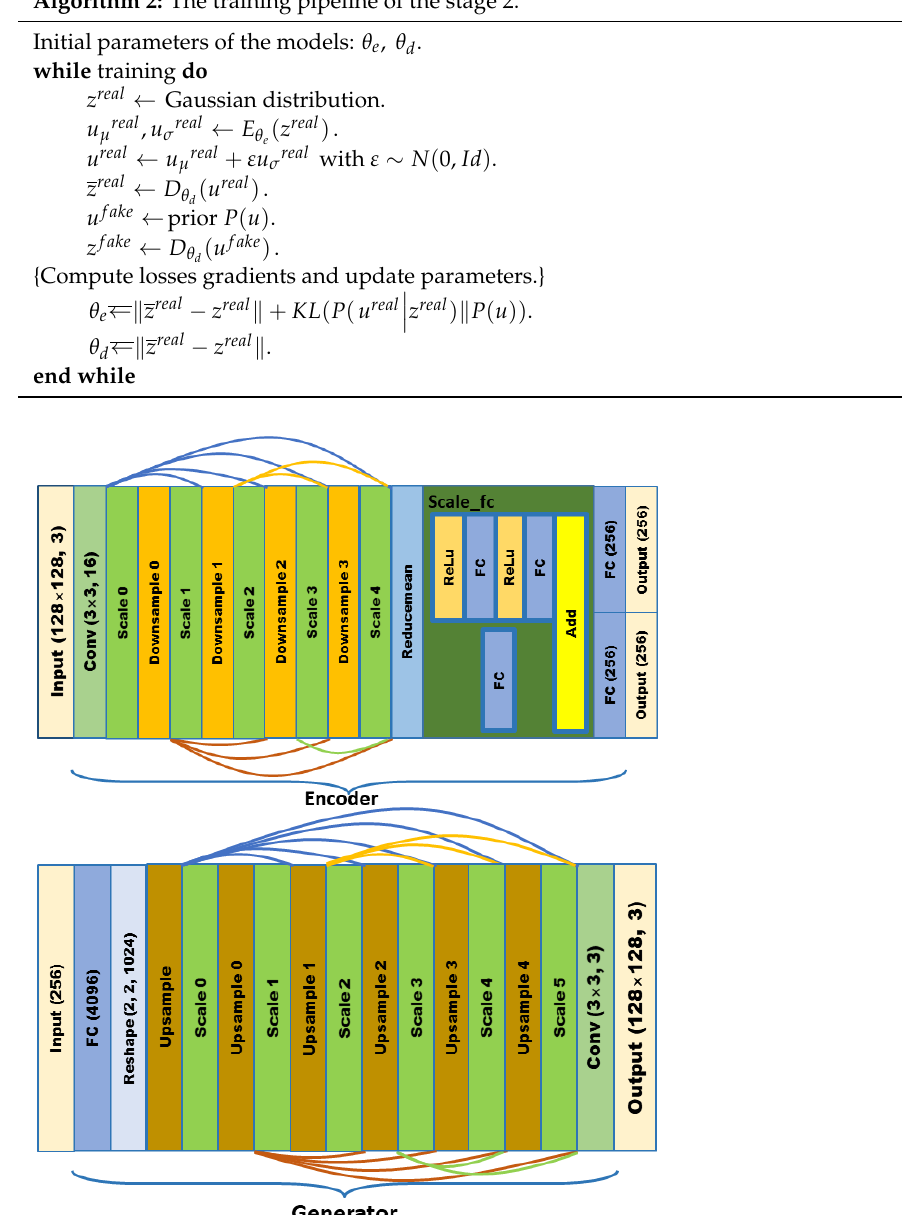
Algorithm 1: The training pipeline of the stage 1.